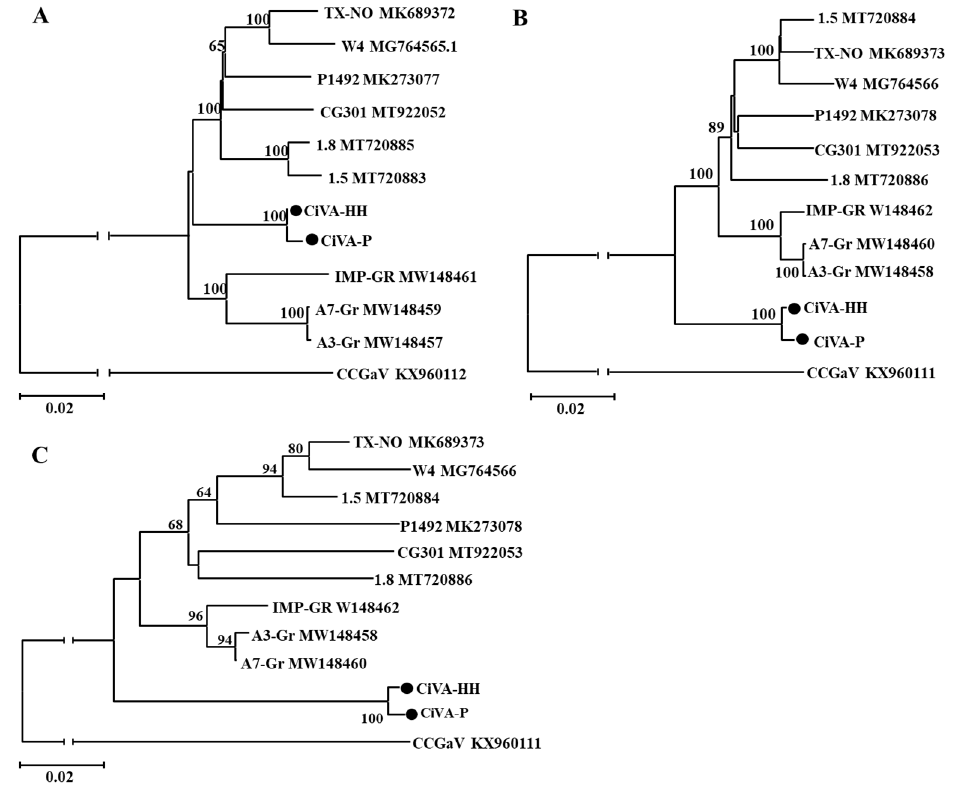
Figure 3. Unrooted NJ phylogenetic trees generated from the nucleotide sequences of RNA1 ( A ), RNA2 ( B ) segments of CiVA. The intergenic region (IGR) ( C ) sequences of CiVA RNA2 were also used for phylogenetic analysis. The corresponding sequence of a reported CCGaVisolate was used as an outgroup in each tree. The referred sequences are marked by their isolate names followed by GenBank accession numbers. Two Chinese CiVA isolates determined by high throughput sequencing are highlighted by black dots.